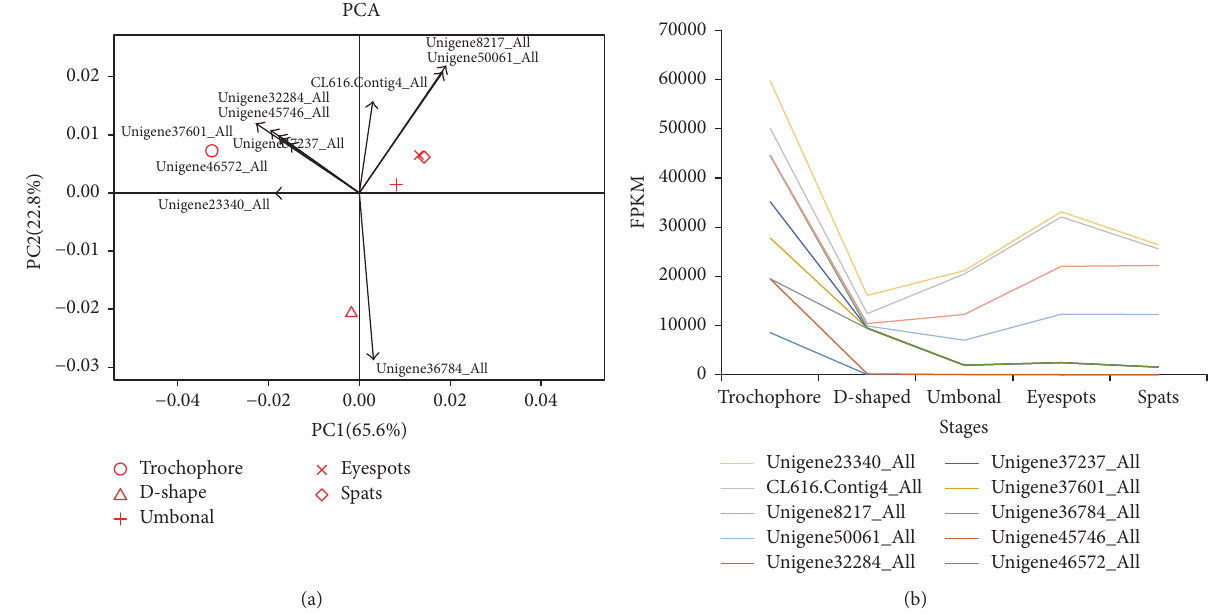
Figure 5: The distinction between five developmental stages as indicated by (a) principal component analysis and (b) expression levels of 10 representative genes, identified to be responsible for the distinction among the developmental stages.